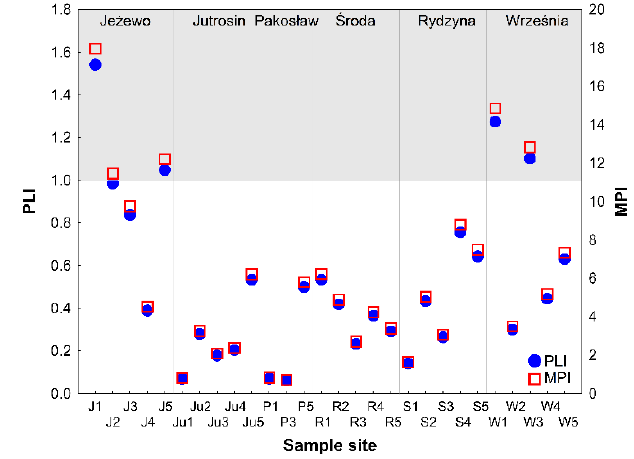
Figure 3. Pollution load index (PLI) and metal pollution index (MPI) values for HMs in bottom sediment sites.